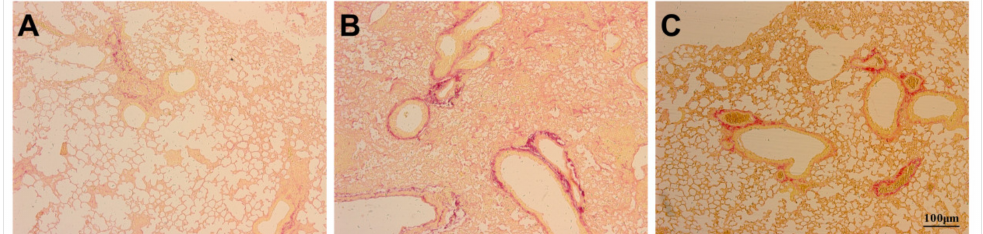
Figure 5. Detection of pulmonary fibrosis in the airway wall: ( A ) Con group; ( B ) Bl group; ( C ) Bl + MSC group; Sirius Red staining revealed collagen fibre deposition in the lung. ( A – C , 100 ×